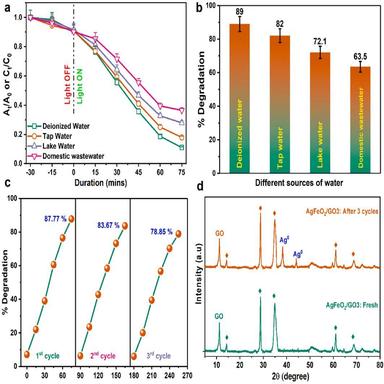
Evaluation of (a), (b) effect of LMF degradation in different sources of water, (c) Study on AgFeO2/GO3 stability and reusability through cycling experimentation, and (d) XRD pattern of pristine AgFeO2/GO3 and recorded after three consecutive photodegradation cycles.